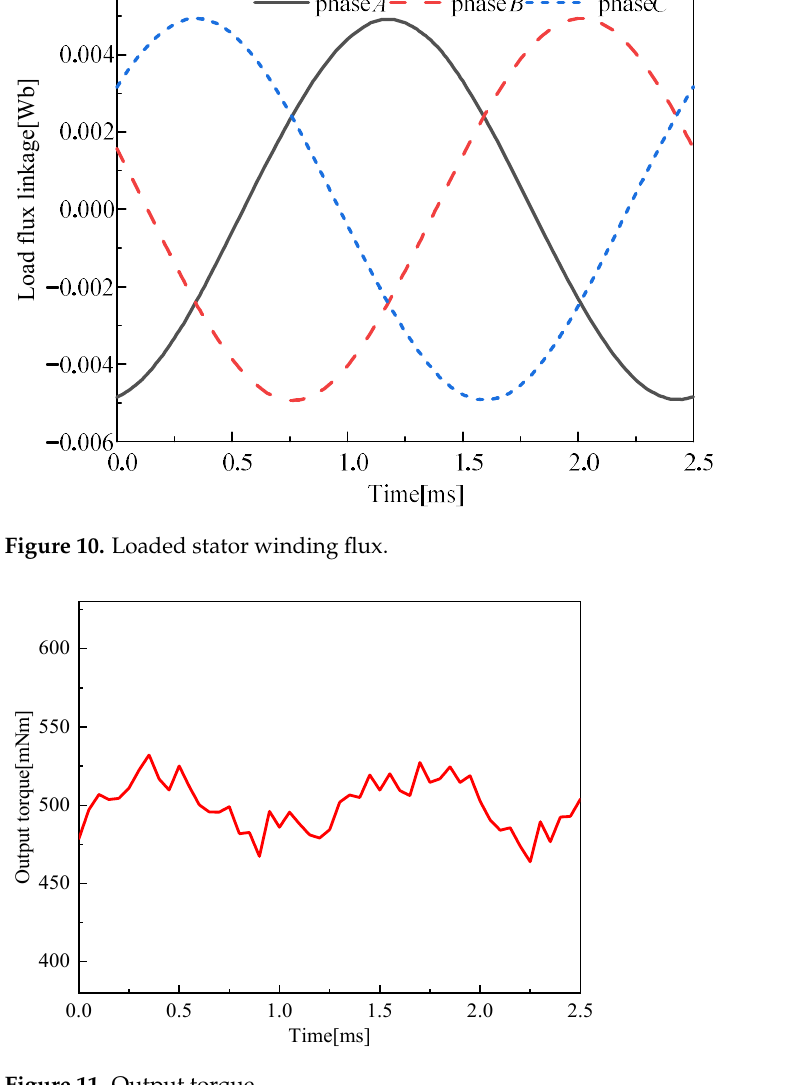
Figure 11. Output torque. Table 2. Output Torque Parameters of AFPMBLDCM.